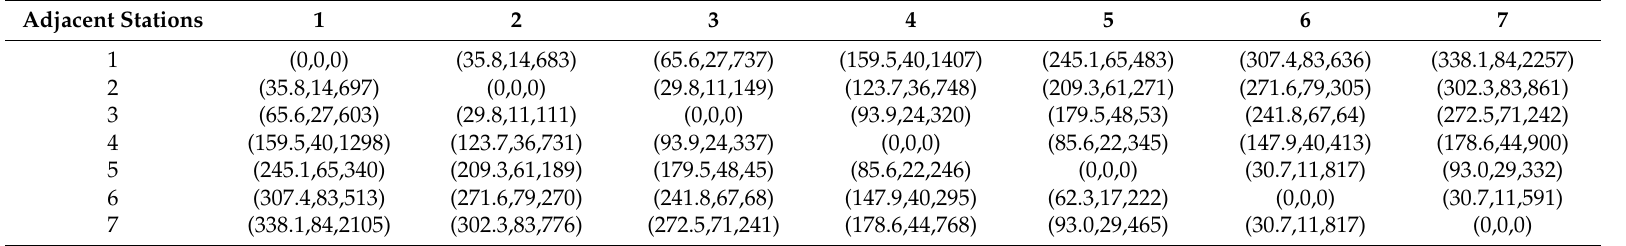
Table 3. Distance, train running time, and planned hourly passenger volume between stations ( N =